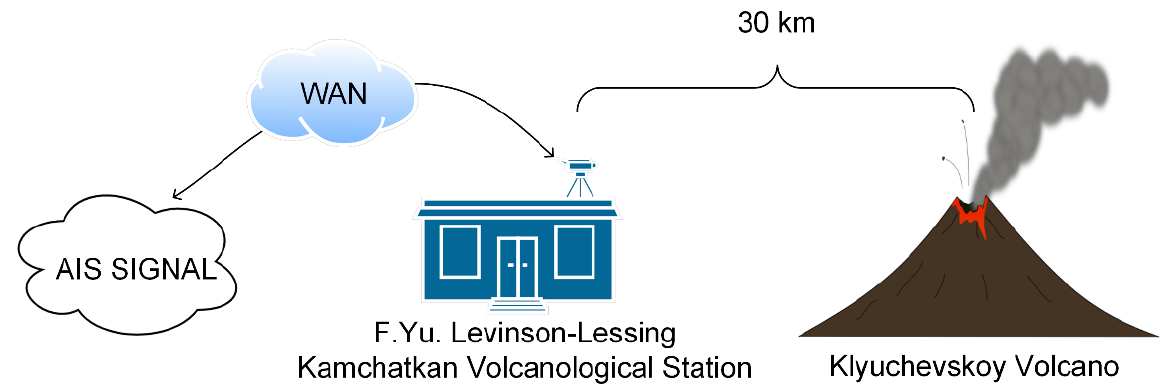
Figure 1. The conceptual observation network dataflow on the example of videocamera capturing the Klyuchevskoy volcano. Images fetched periodically and transmitted via wide area network (WAN) to automated information system (AIS) “SIGNAL”.